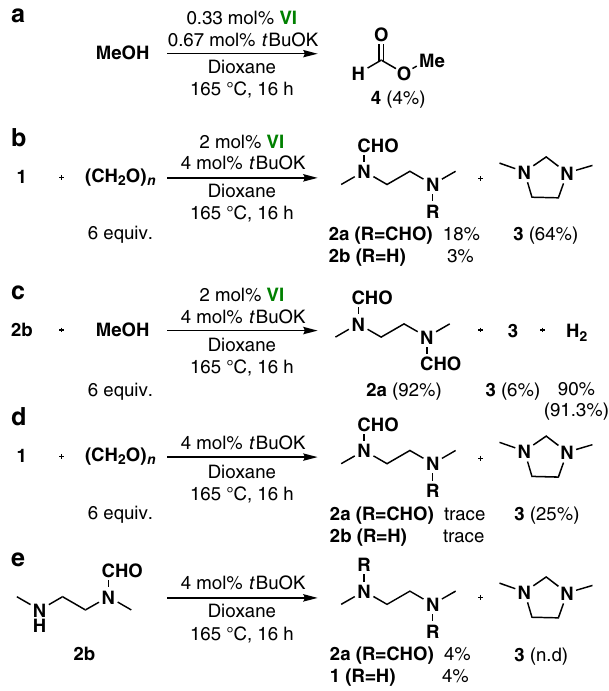
Fig. 4 Control experiments for mechanistic study. a VI -catalyzed dehydrogenation of methanol. b Dehydrogenative condensation of 1 with paraformaldehyde. c Dehydrogenative condensation of 2b with methanol. d Condensation of 1 and paraformaldehyde without Mn catalyst. e Reactivity of 2b without Mn catalyst.